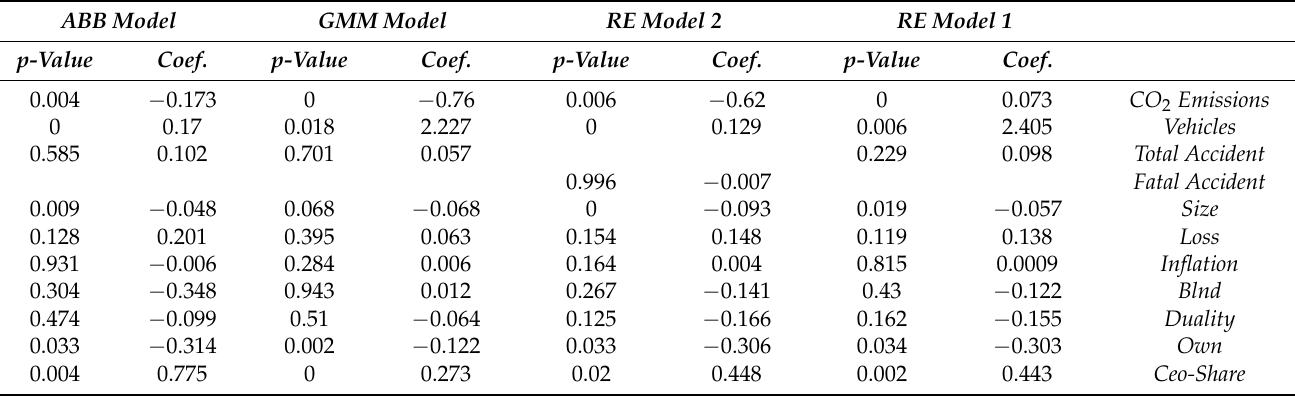
Table 6. The results of the effect of CO 2 emissions on stock returns of automotive